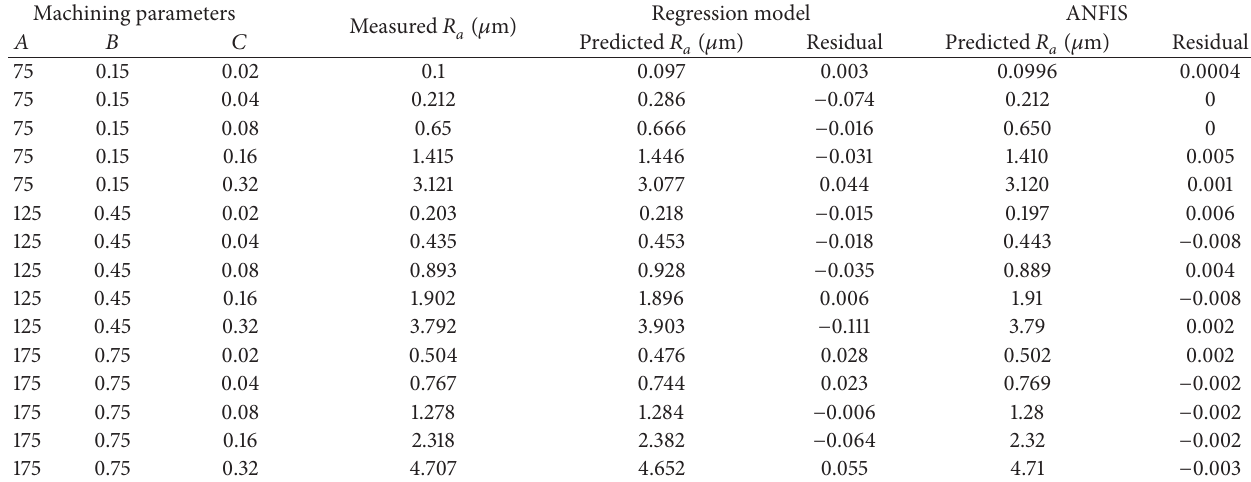
Table 6: Comparison between regression model and ANFIS predictions.